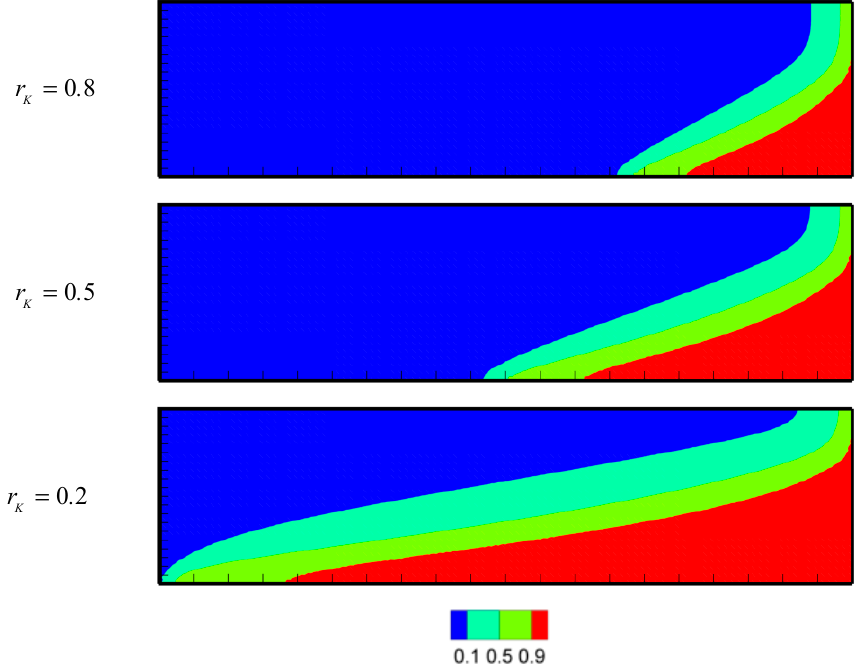
Figure 6. Effect of anisotropy on the isochlors’ positions (90%, 50%, 10%): Results obtained for the dispersive homogenous case (see Table 1 for all parameters, except r K , which is given in the